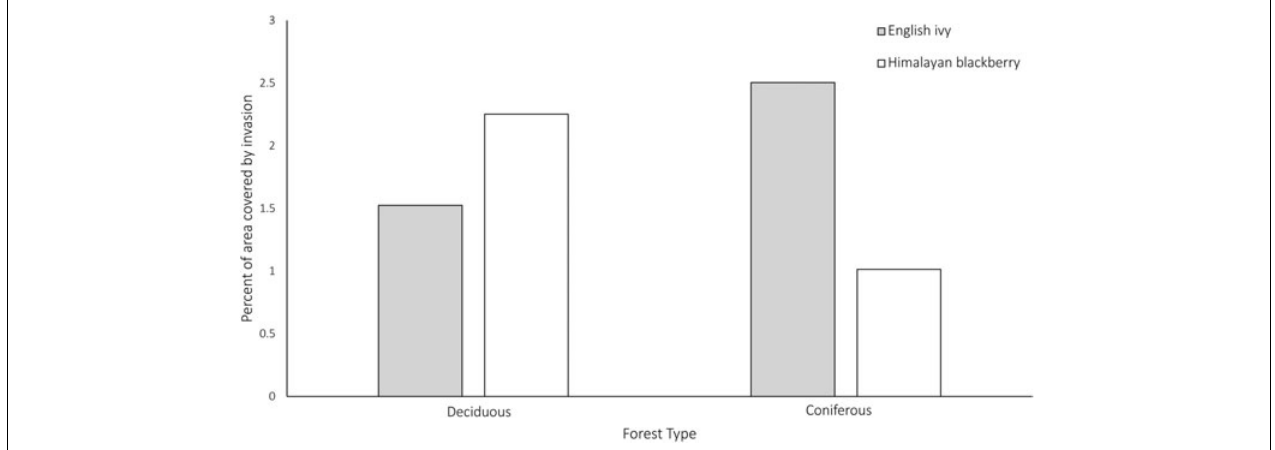
FIGURE 7 | Percent of area covered by Himalayan blackberry ( Rubus armeniacus ) and English ivy ( Hedera hel ix) in deciduous and coniferous forests in Surrey, BC, Canada. N = 1179195 for Himalayan blackberry and N = 1507252 for English